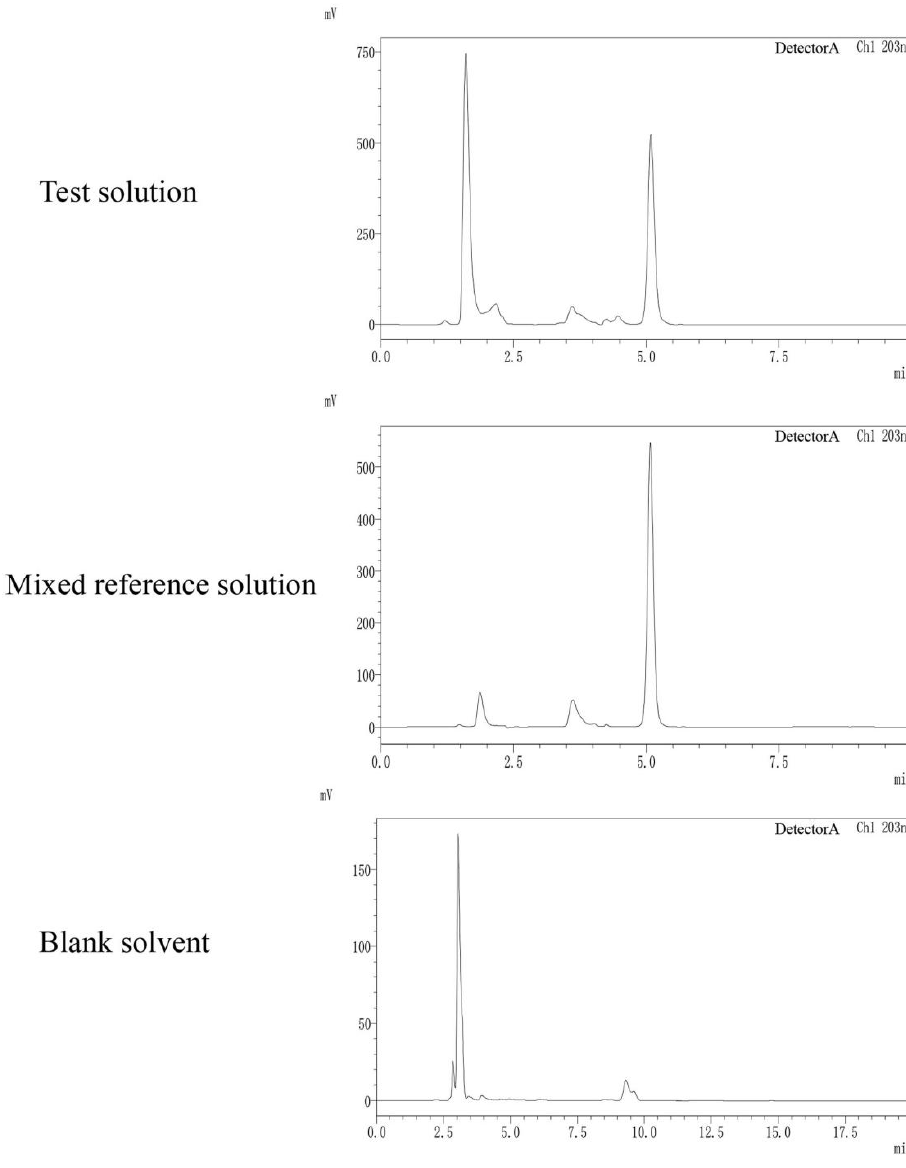
Figure 9. HPLC chromatograms of test solution, mixed reference solution and blank solvent. Table 11. Correlation between standard concentration and area under peak of chemical components in the kernel of P. mira